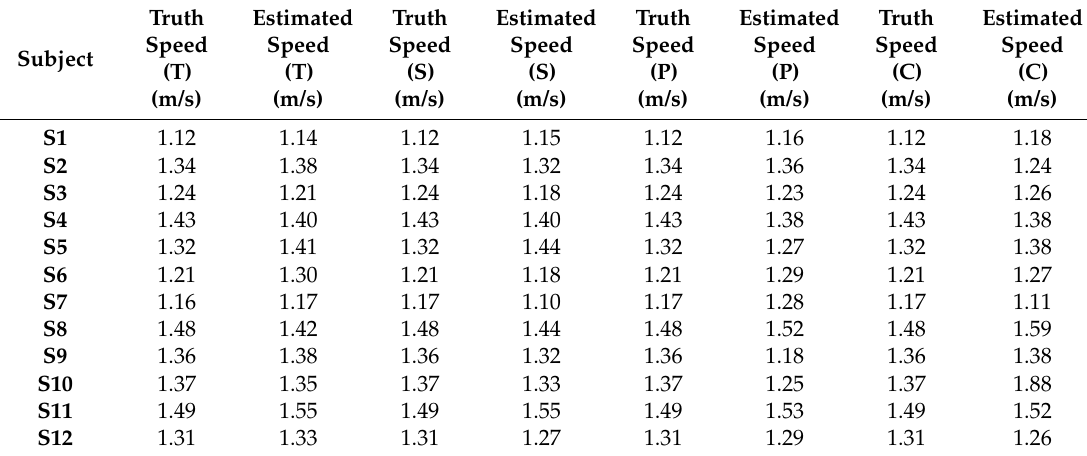
Table 8. Metrics for evaluating the pedestrian walking speed estimation method with different pose.